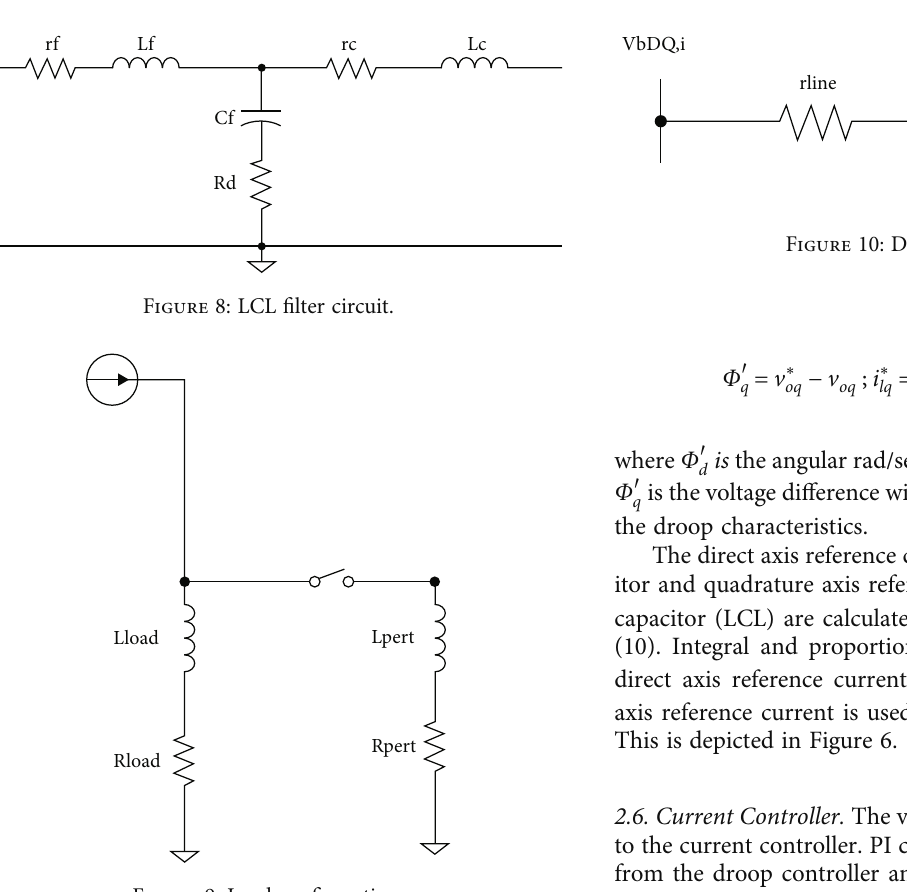
Figure 9: Load con fi guration.